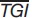
Density plots depicting the distribution of time to global infection (TGI) for transmission-potential networks (TPNs).TPNs were of equal size and connectance under three conditions: single-species, multi-species with θ
m (infection probability) varying among species and multi-species with fixed θ
m = 0.02. Each panel describes a comparison of a given single-species network to multi-species networks in a given locality: (A) Bandicota savilei in Buriram; (B) and (C) B. savilei and Rattus tanezumi in Mondolkiri, respectively; (D) and (E) R. exulans and R. tanezumi in Sihanouk, respectively. Plots skewed to the left indicate a faster infection and curve height is indicative of the probability that global infection occurs at a certain pace. Insets in A-E show the overlap between two curves (depicted by the colored circle above the bar) calculated as the integral of the area common to both curves. (F) The deviation in median TGI¯ of the multi-species networks with fixed (blue circles) or non-fixed (yellow circles) θ
m from median TGI¯ of the single-species network. The deviation was calculated for each of the panels A-E. Small overlap and a greater deviation of the median between the single-species and the multi-species plots mean that the inclusion of other species changes the velocity of parasite spread.